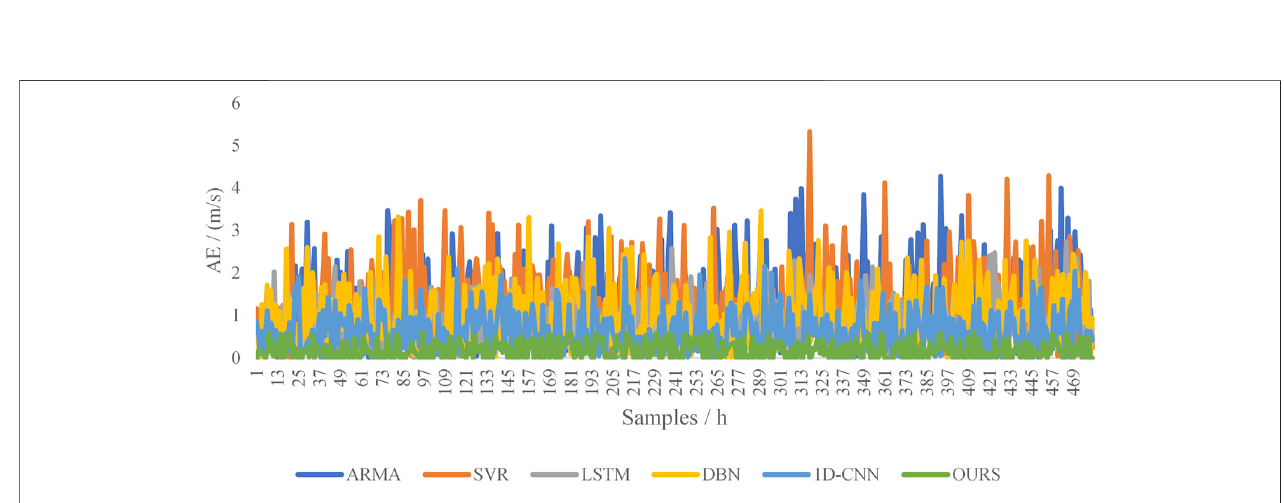
FIGURE 13 | Absolute errors of the different models.